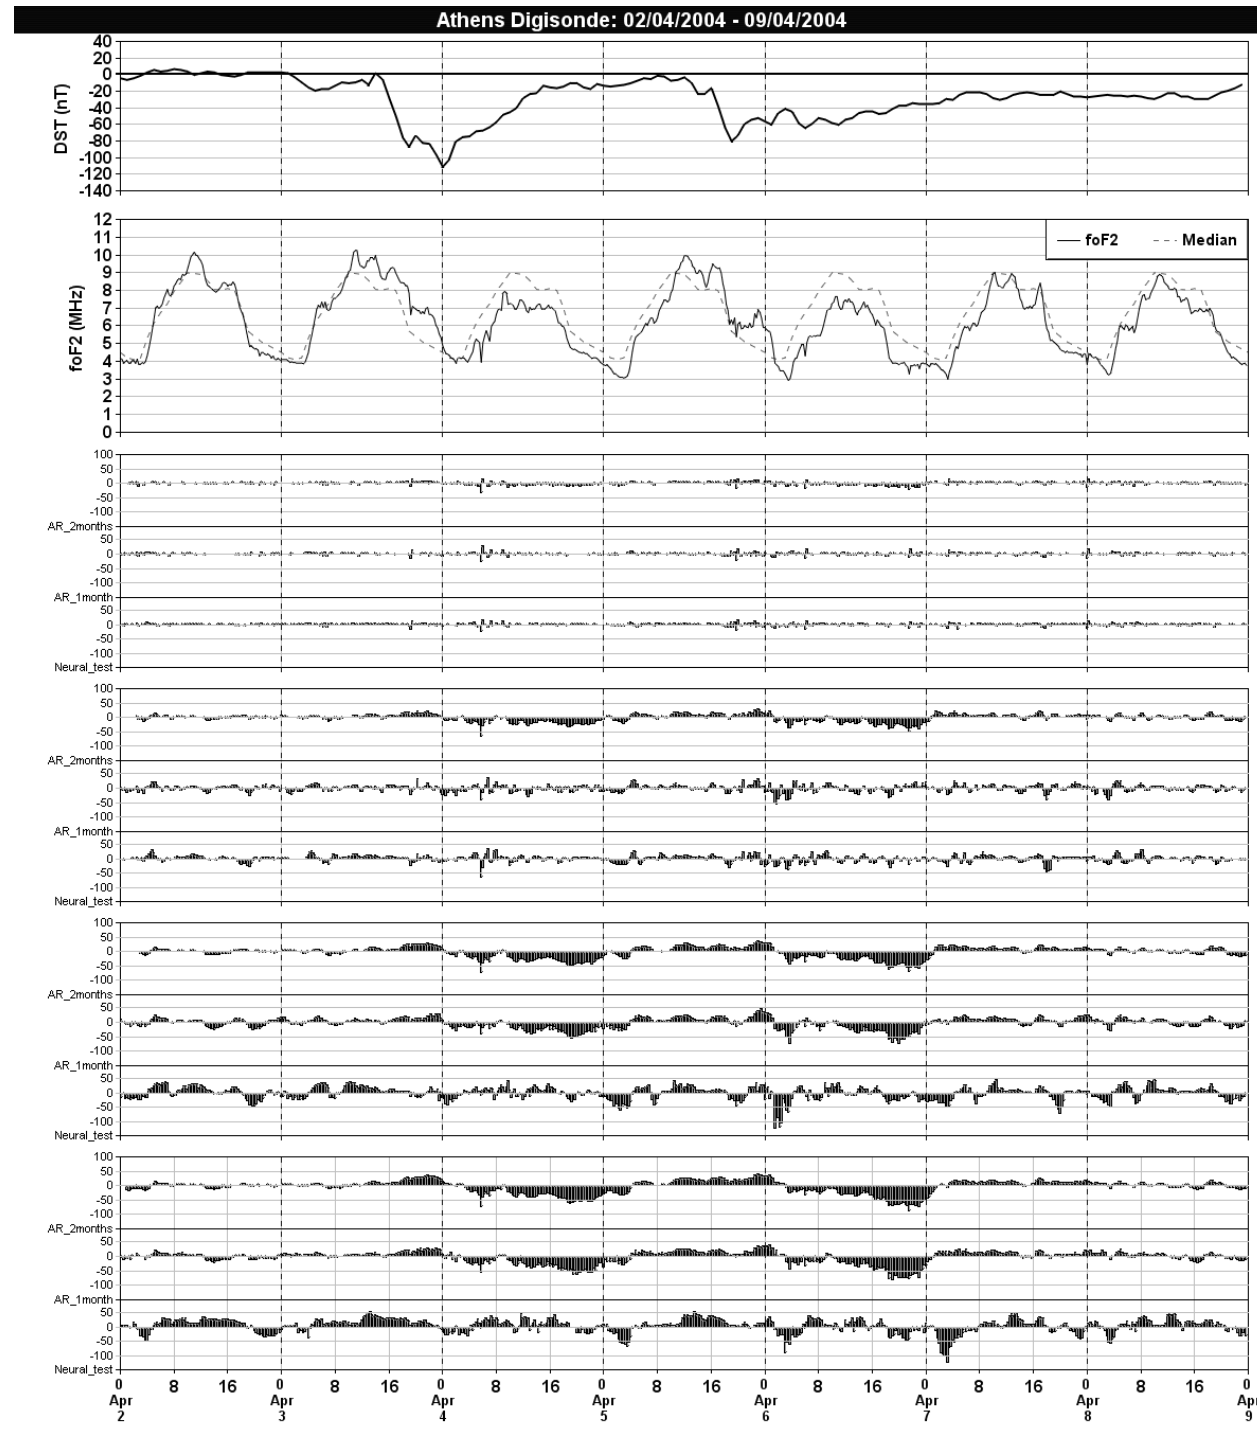
Fig. 4. The same as Fig. 2 for the storm interval 2–8 April